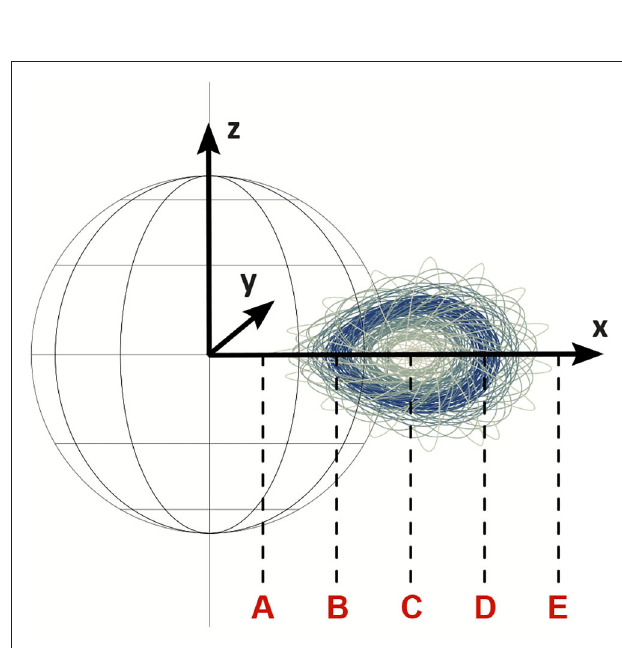
FIGURE 3 | The coordinates used in the model. The Sun-Earth line is along ˆ x axis. The dotted lines show the location of the “key” points along ˆ x axis, from left to right: back of the bubble A , back end of the minor axis B , major axis C , front end of the minor axis D , and front of the bubble E